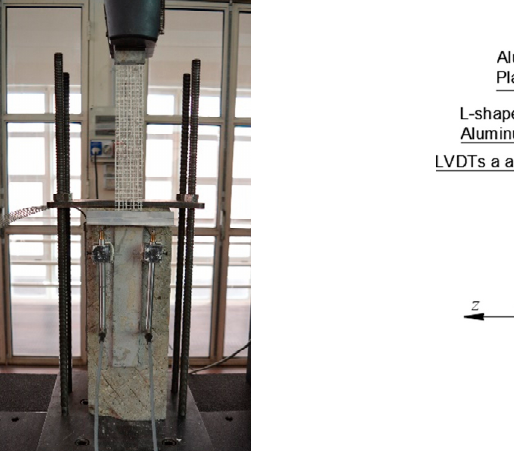
Figure 4. Direct shear test: Test setup and scheme.